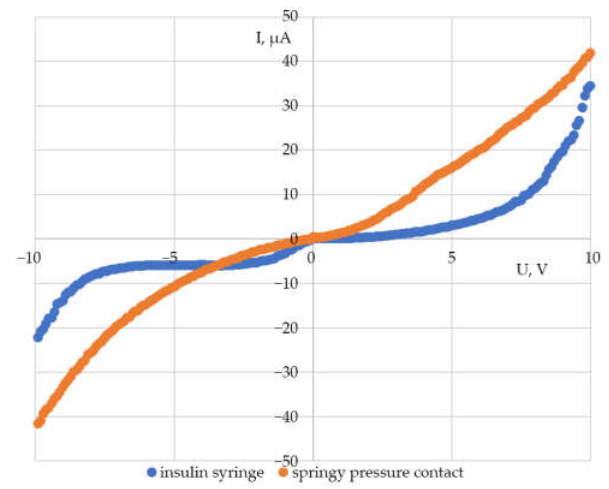
Figure 11. The current–voltage characteristics of the sample with three different electrode pressures on it: Pa < Pb < Pc.